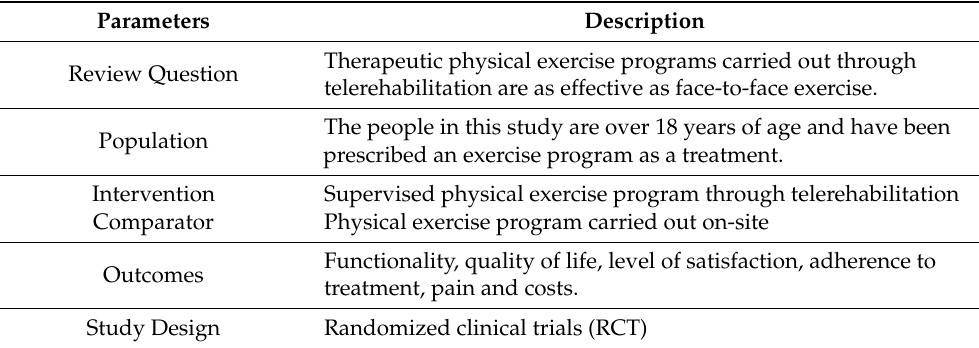
Table 2. Details and PICOs composition for the inclusion of